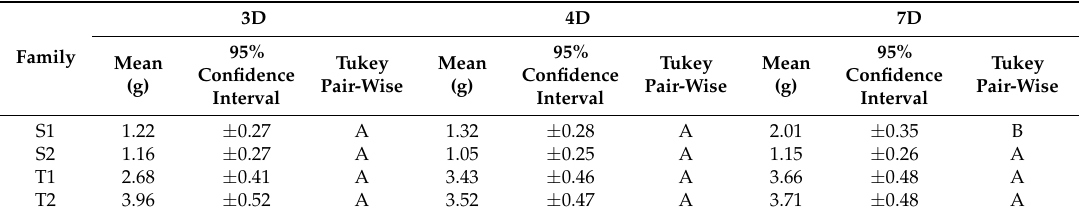
Table 8. Summary of seedling coarse root dry matter yield (DMY, g) by rainfall and family.